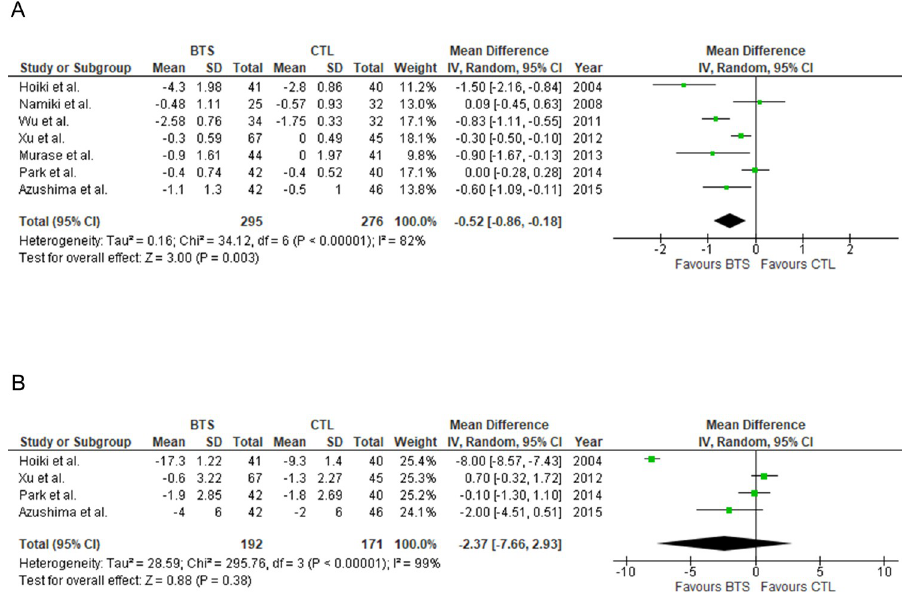
Fig 3. Meta-analysis of the efficacy of BTS for BMI and waist circumference reduction. (A) Body mass index. (B) Waist circumference. BTS, bofutsushosan group; CTL, control group.